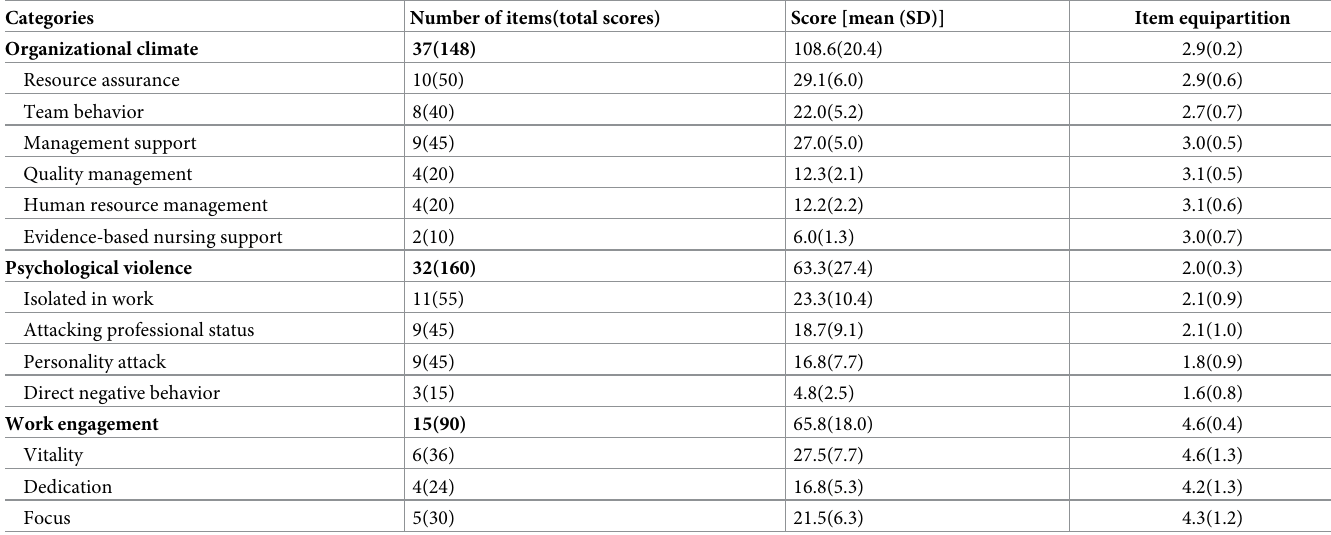
Table 1. The score of psychological violence, organizational climate, work